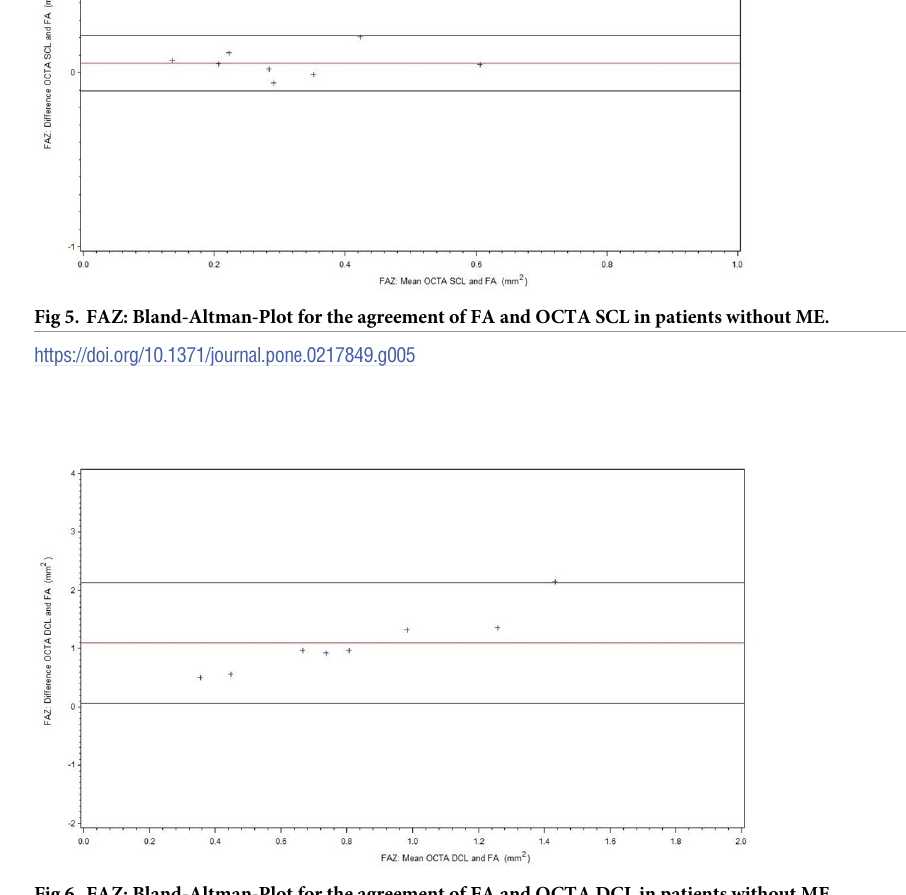
PLOS ONE | https://doi.org/10.1371/journal.pone.0217849 June 4,